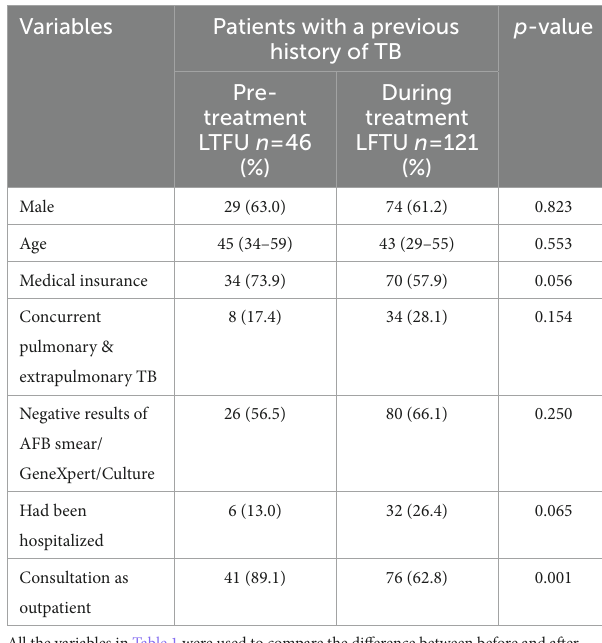
TABLE 2 Difference in characteristics of loss to follow-up (LTFU) between pre-treatment and during tuberculosis (TB) treatment in patients with a previous history of TB ( n = 167).